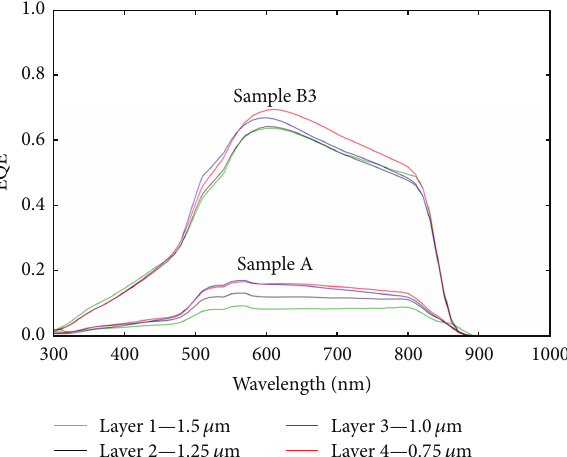
Figure 7: The quantum efficiencies for the best performing cells from the CdS/CdTe solar cells made without (sample A) and with (sample B3) CdCl 2 annealing at 360 ∘ C for